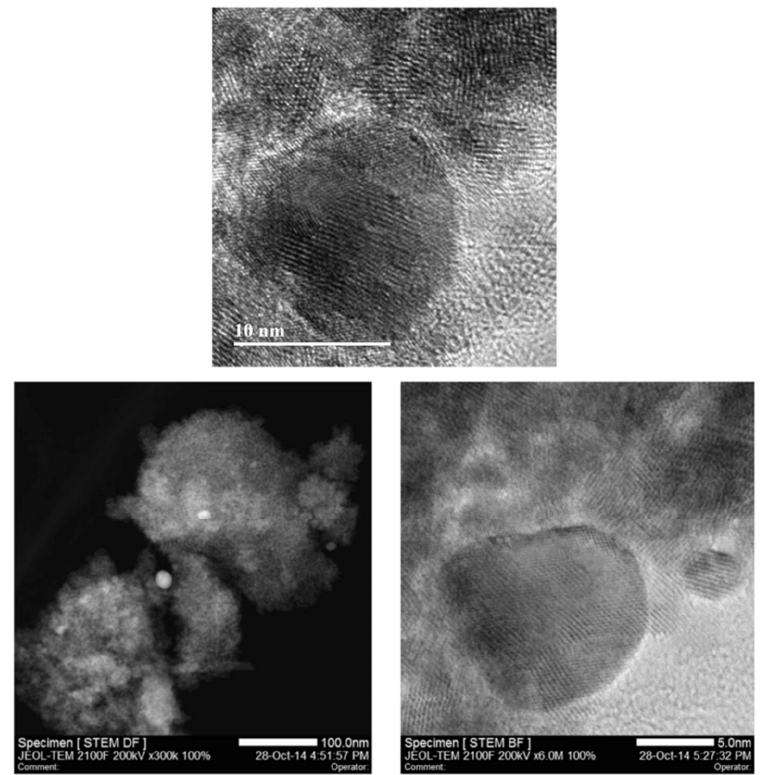
Figure 1. Representative HR-TEM ( Top ), dark Field ( Bottom , Left ) and bright Field ( Bottom , Right ) HR-STEM images of the 0.82% Au/CeO 2 catalyst. The high-resolution image allows one to distinguish the crystal planes corresponding to Au particles. Au element is well distributed in the particles, as observed in the bright field image. Therefore, we performed a dark field scanning electron microscopy of 0.82% AuCeO 2 catalyst and EDX elemental mapping. Elemental mapping at the microscopic level of this catalyst (presented in Figure 2) revealed a homogeneous dispersion of Au on the CeO 2 support in a sample of 0.82 wt% Au/CeO 2 ; i.e., there was a similar distribution of both elements.